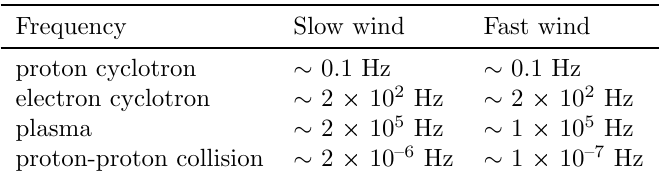
Table 8: Typical values of different frequencies at 1 AU. These values have been obtained from the parameters reported in Table